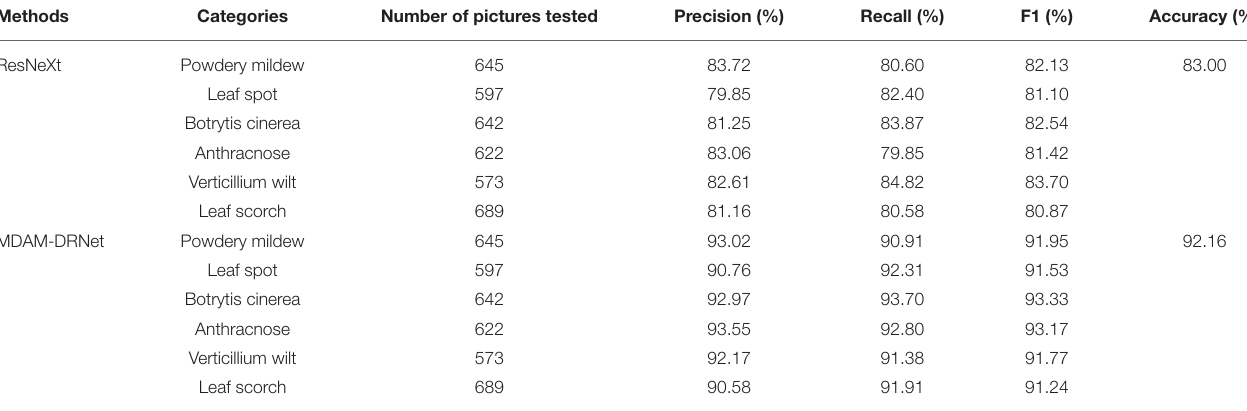
TABLE 5 | Effect of MDAM-DRNet model on early disease identification of strawberry leaves.